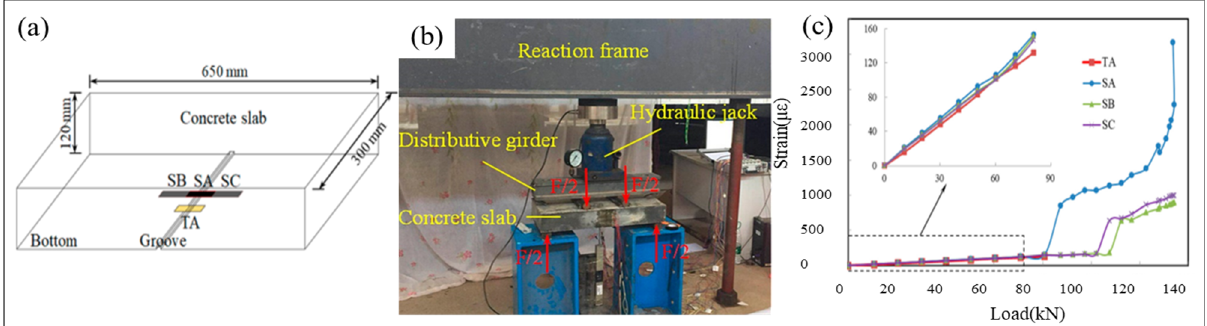
Figure 8. Deformation and crack monitoring [143] ( a ) the positions of the film sensor and resistance strain gauge; ( b ) four-point loading chart; ( c ) strains of composite film sensors (SA, SB, and SC) and traditional resistance strain gauge (TA) during loading. (open access, MDPI).